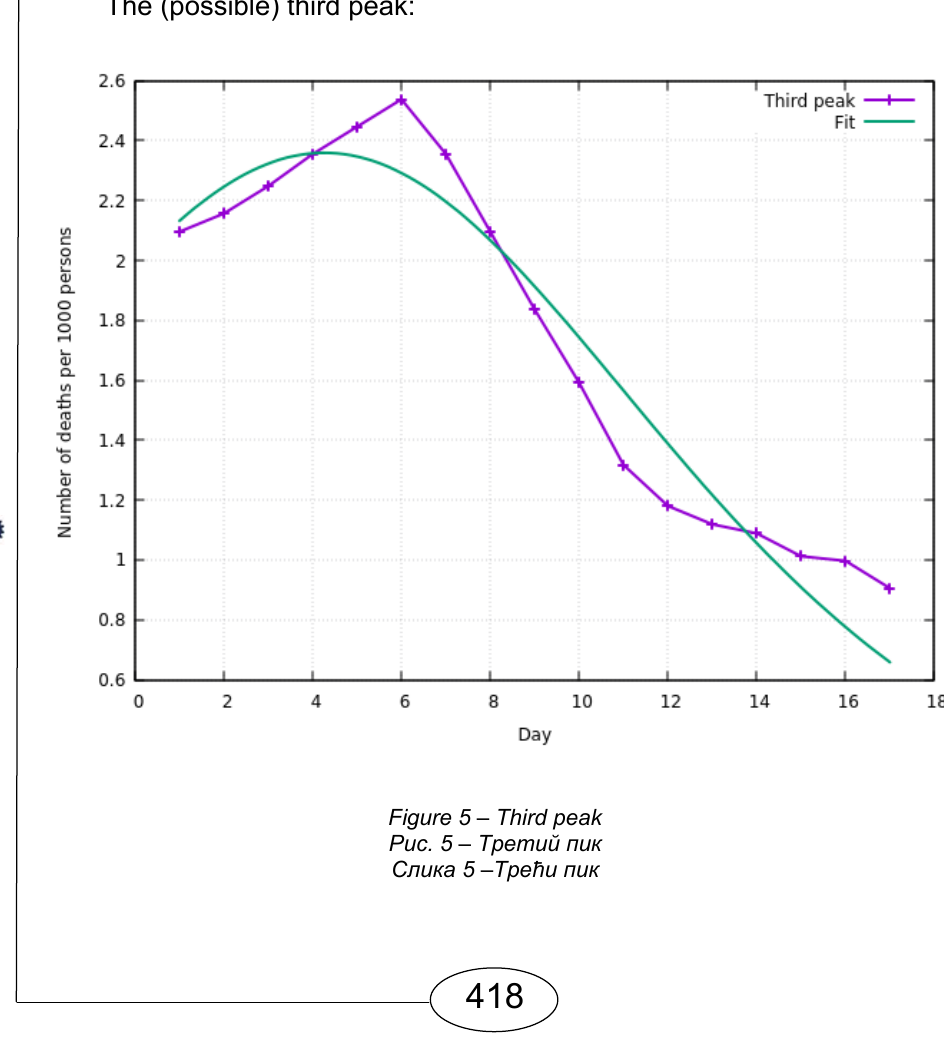
Figure 5 – Third peak Рис . 5 – Третий пик Слика 5 – Трећи